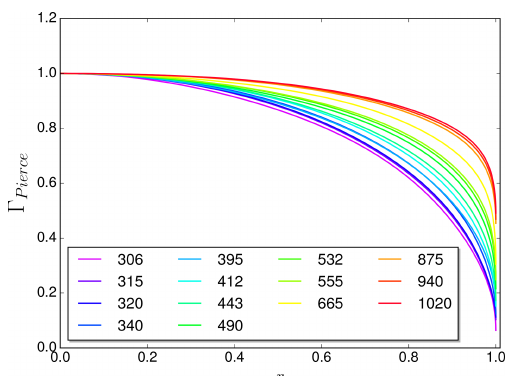
Figure 5. Values of the limb darkening factor (cid:48) based on Pierce and Slaughter (1977) and Pierce et al. (1977). Curves are for differ- ent wavelengths, given in nanometers. r denotes the position on the visible solar disk, with r = 0 at the center and r = 1 at the